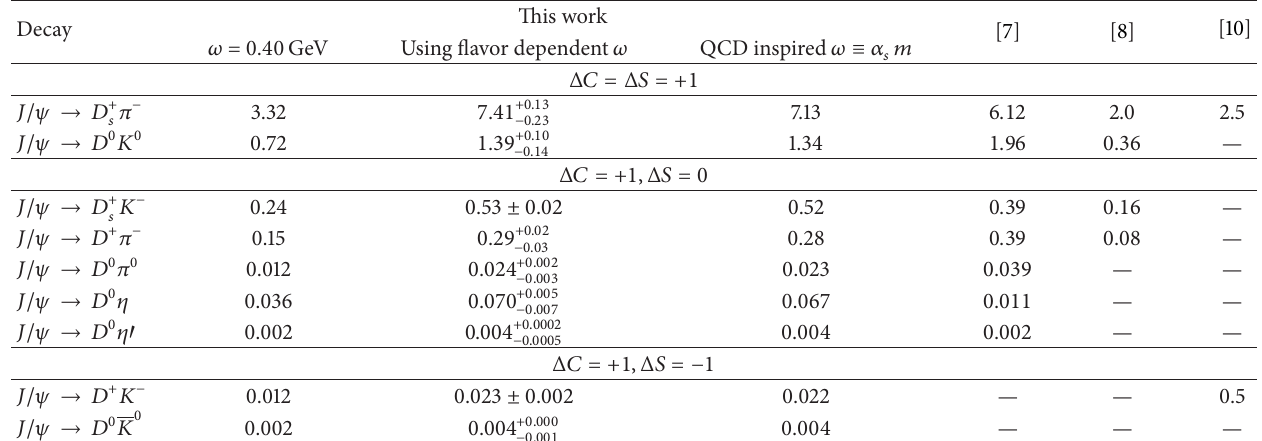
Table 4: Branching ratios (in the units of 10 −10 ) of 𝐽/𝜓 → 𝑃𝑃 decays.